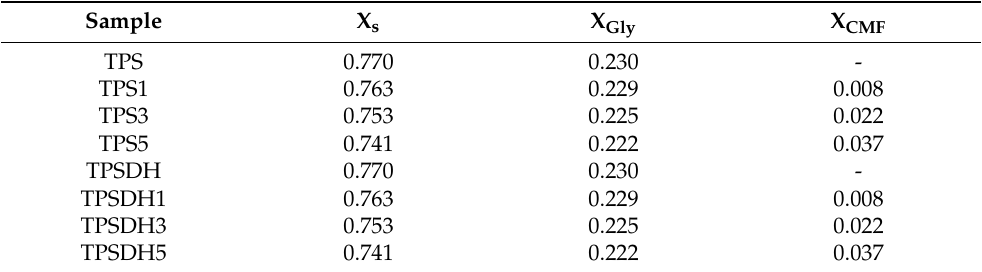
Table 1. Summary of compositions according to the mass fraction (g/g) of thermoplastic corn starch (TPS), thermoplastic dry heated corn starch (TPSDH), glycerol (Gly), and cellulose microfiber (CMF).